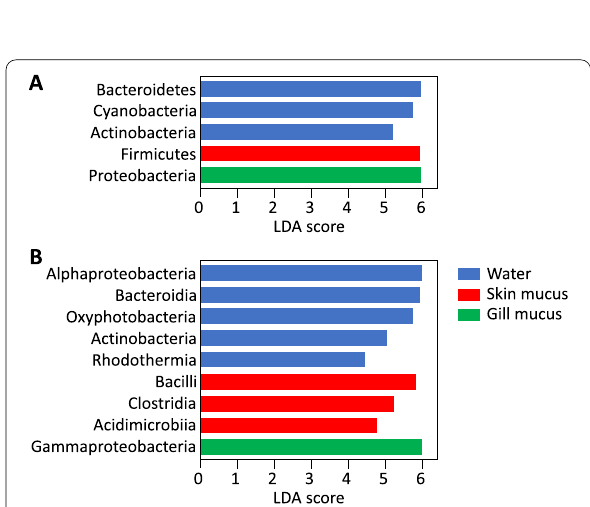
Fig. 4 Most contributing taxa to differences between water (blue), skin (red) and gill (green) bacterial communities. A phylum, B class level. LDA scores were calculated using Linear discriminant analysis Effect Size (LEfSe), only bacterial taxa that raised an LDA score > 4